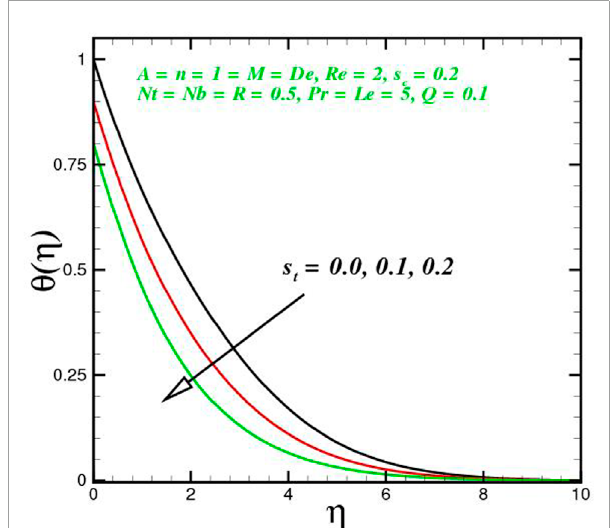
FIGURE 7 θ ( η ) , alteration via R.